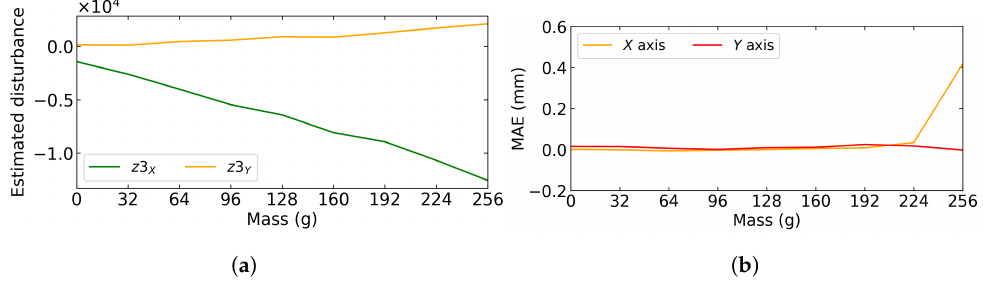
Figure 20. Generalized disturbance estimation and mean steady state error for X and Y axes to different values of radial load aligned with the X -axis. ( a ) Generalized disturbance estimation ( z 3 ). ( b ) Mean absolute error for X and Y axes.